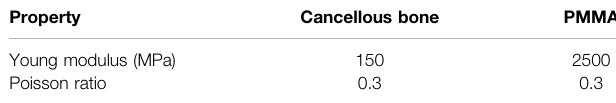
TABLE 3 | Material properties used for FE analysis.